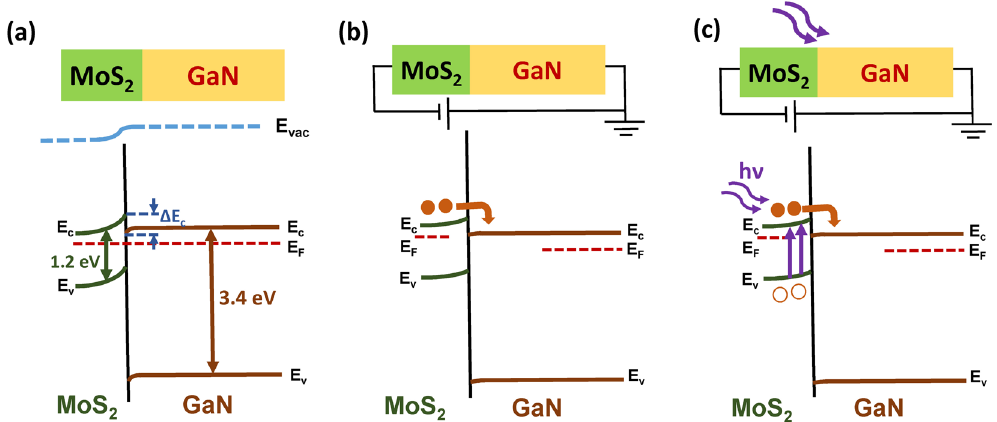
Figure 5. Energy band diagram of the heterojunction. ( a ) After contact (zero bias). ( b ) Forward bias (negative bias is given to MoS 2 with respect to GaN). ( c ) Forward bias under photoexcitation with laser wavelength 405 nm. E c , E v , E F and E vac represent bottom of conduction band, top of valence band, Fermi level and vacuum level, respectively. Band gap of MoS 2 and GaN is 1.2 eV and 3.4 eV, respectively. Δ E c represents the conduction band